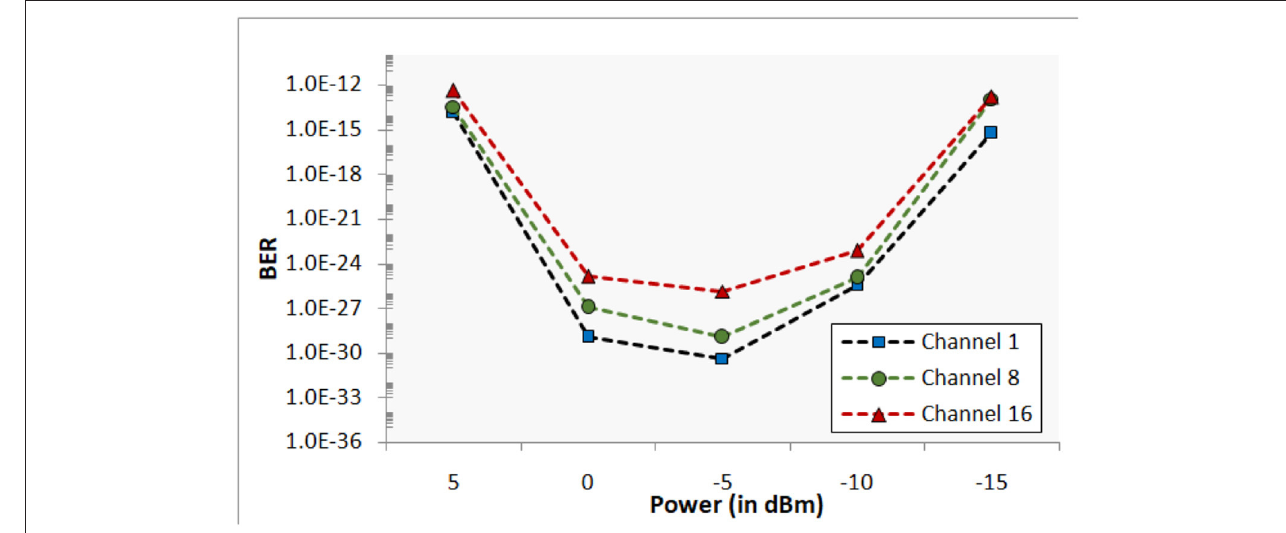
FIGURE 10 | Variation of BER with power at channel spacing of 50